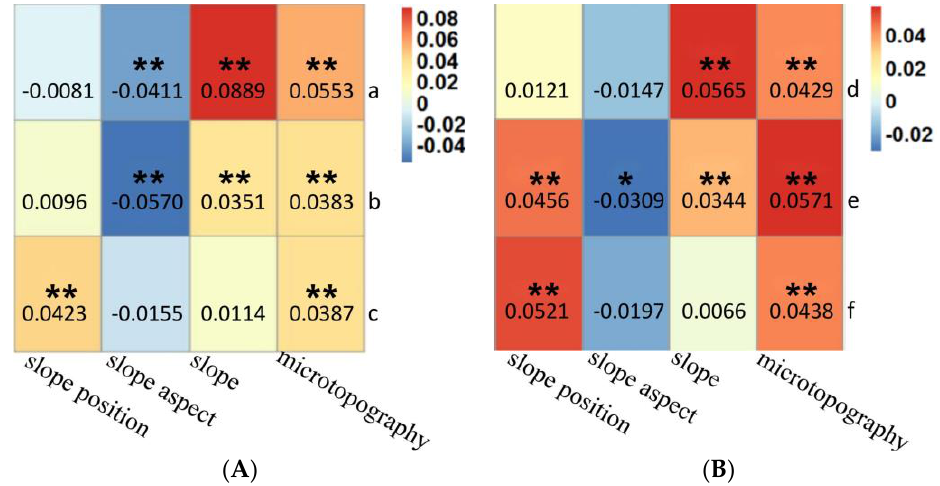
Figure 7. Correlation between topography and the quantity of tree species with different mycorrhizal types( A ); Correlation between DBH changes of tree species with different mycorrhizal types and topography( B ); Changes in the quantity of AM type tree species (a); Changes in the quantity of EcM type tree species (b); Changes in the quantity of ErM type tree species (c); DBH sum changes of AM type tree species (d); DBH sum changes of EcM type tree species (e); DBH sum changes of ErM type tree species (f). * indicated significant correlation at p < 0.05 level. ** indicated significant correlation at p < 0.01 level.